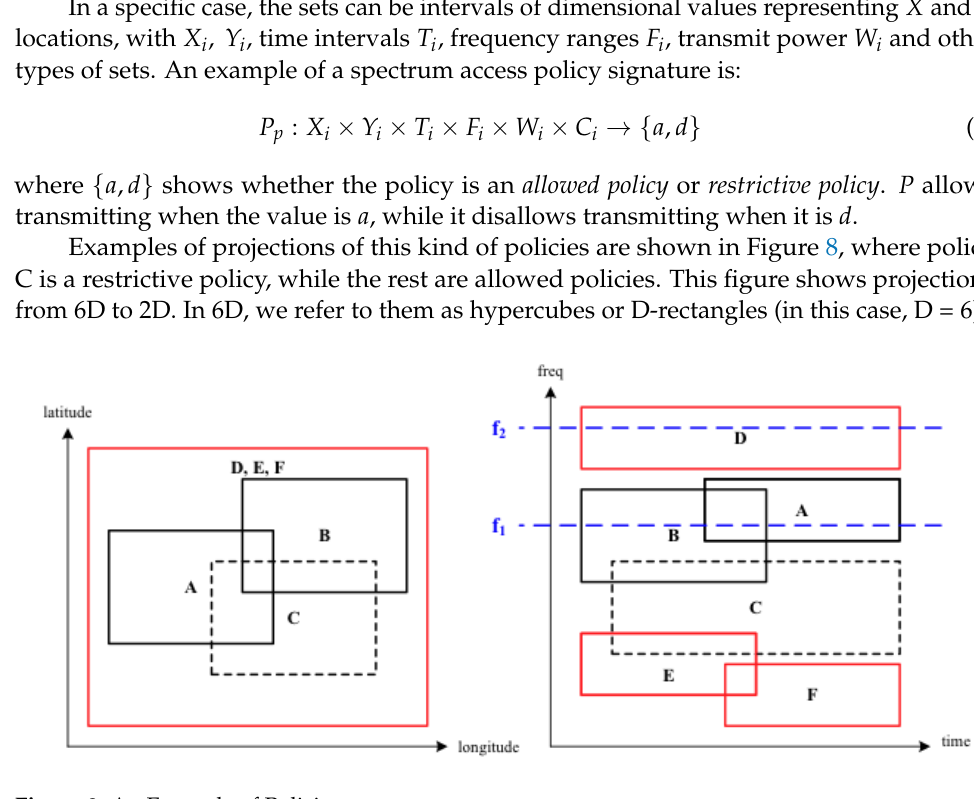
Figure 8. An Example of